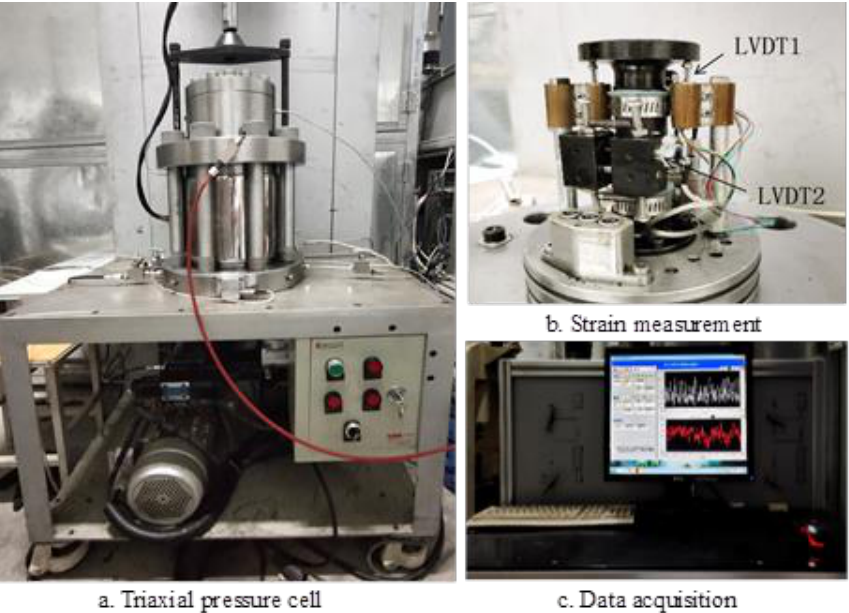
Figure 2. Servo-controlled triaxial equipment during laboratory tests.